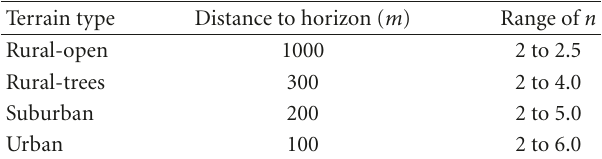
Table 2: Terrain type parameters.